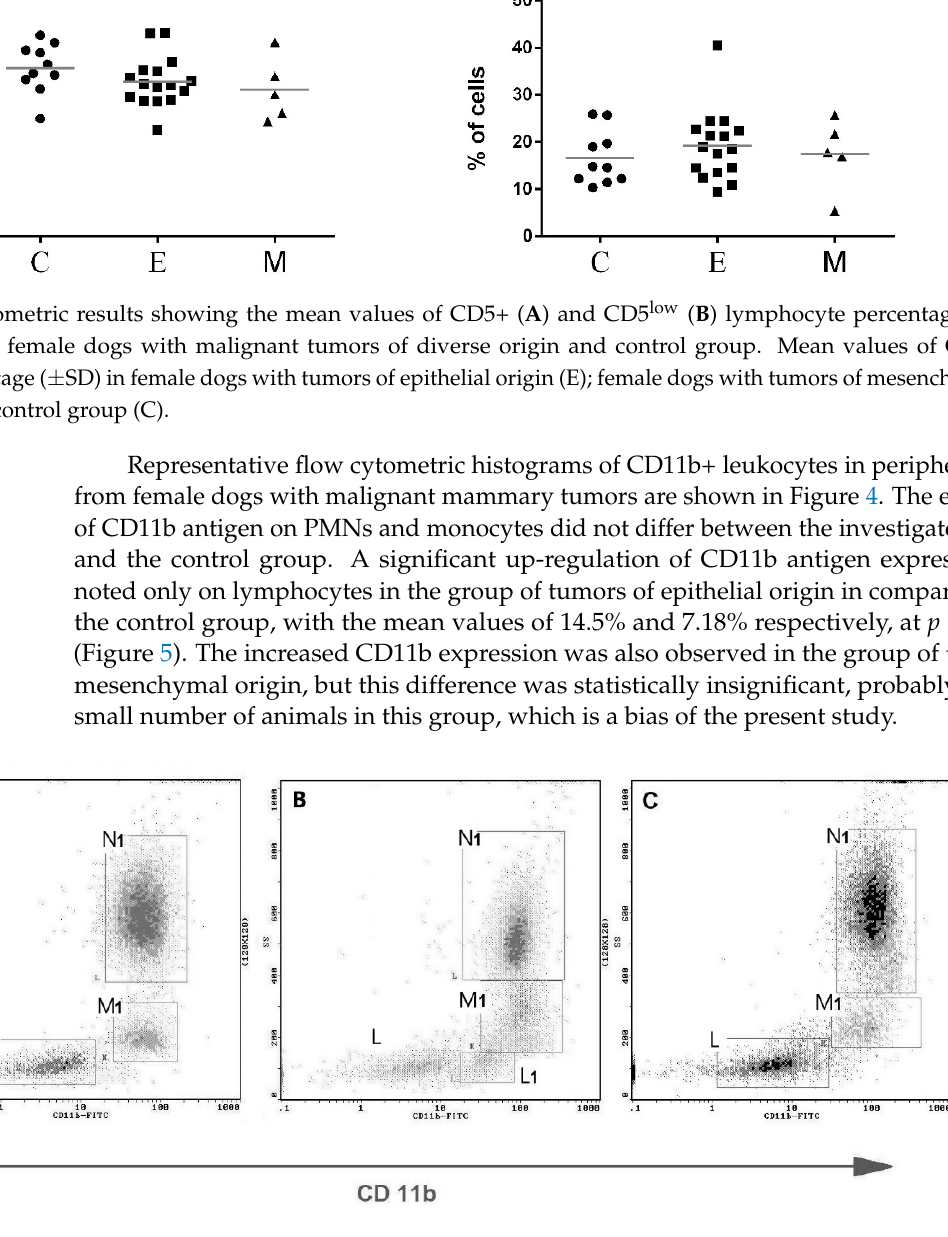
Figure 2. Representative flow cytometric analysis of CD5+ lymphocytes in blood of bitches with malignant mammary tumors. Dot plots showing CD5 expression on canine lymphocytes from ( A ) the healthy bitch, ( B ) the bitch with osteosar- coma, and ( C ) the bitch with complex carcinoma G2. Two subpopulations of CD5+ lymphocytes are visible: CD5 low lym- phocytes (gate G) and CD5 high lymphocytes (gate F).